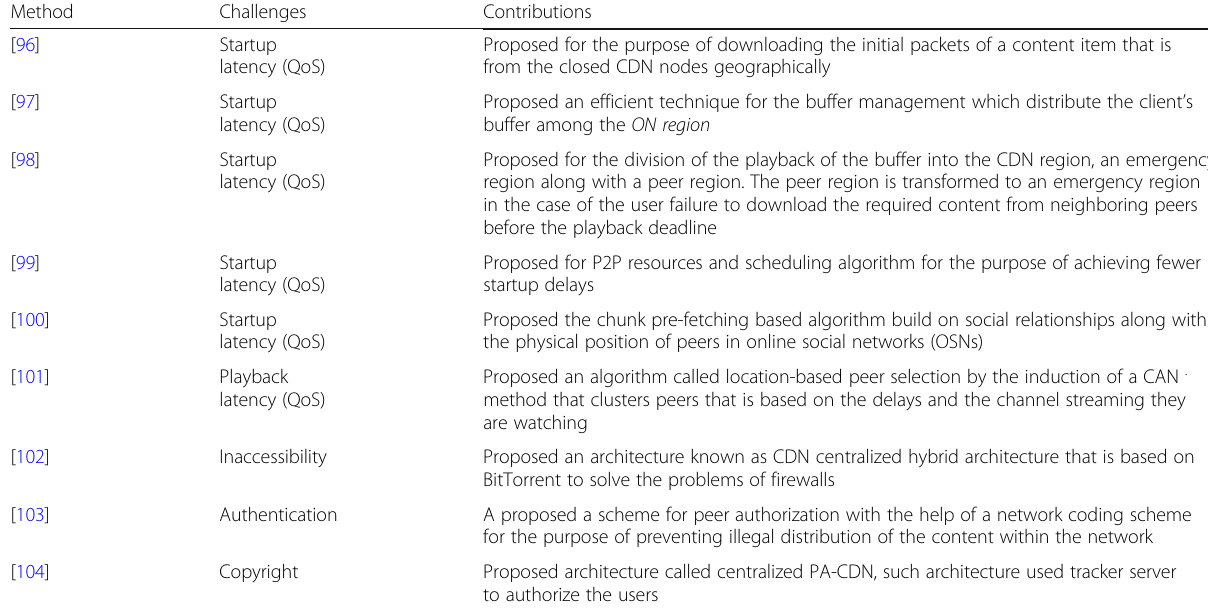
Table 6 CDN challenges in MSN Method